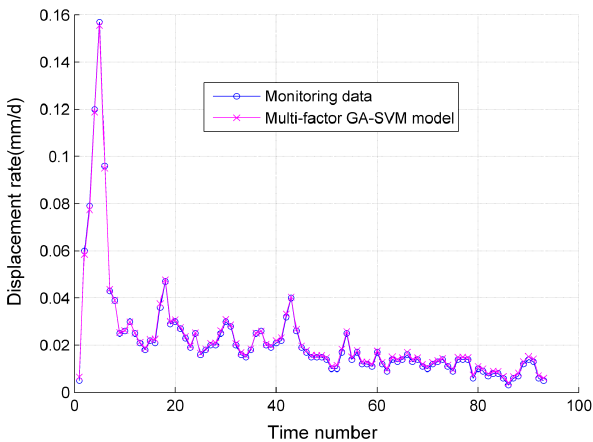
Fig. 10. The 3-D contour map of the parameter selection of the single-factor SVM model by using grid-search method.